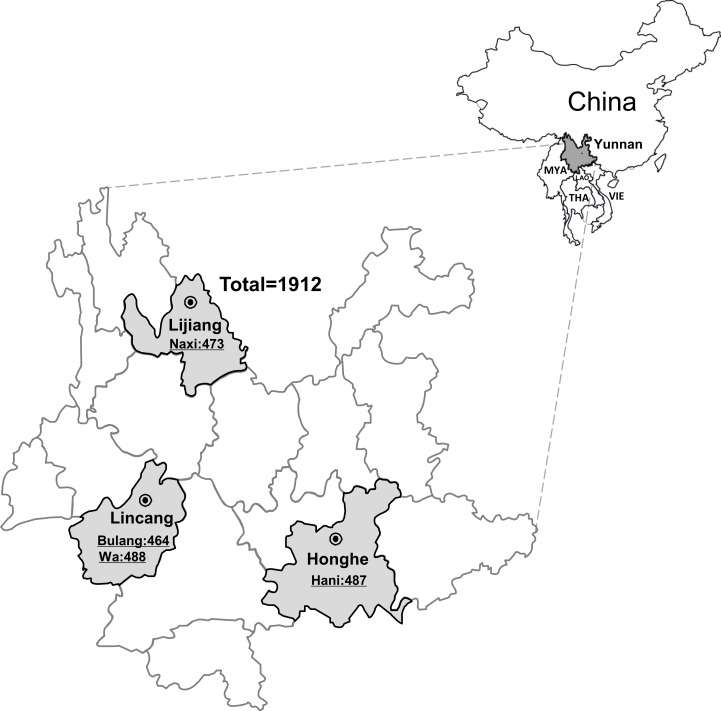
Maps of the study region and geographical distribution of subjects from all three prefectures of the Yunnan province of southwestern China.The Yunnan province of southwestern China is marked in dark gray, the Lijiang prefecture, Lincang prefecture, and Honghe prefecture are highlighted in light gray, respectively. MYA: Myanmar; THA: Thailand; LAO: Laos; VIE: Vietnam.